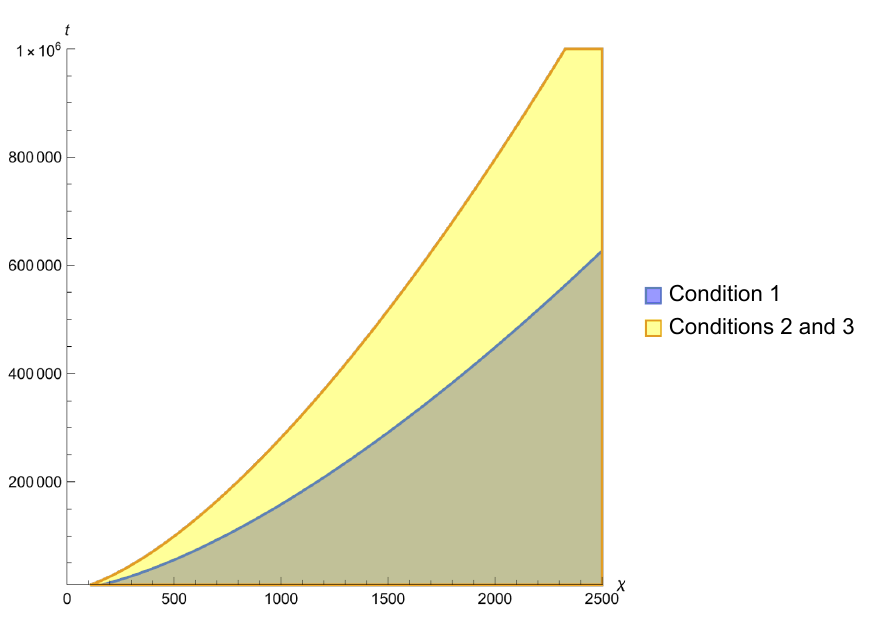
Figure 4 . Regions satisfying the island conditions are shown for a flat universe with w = 1 , ρ 0 = 10 − 6 , T 0 = 10 − 4